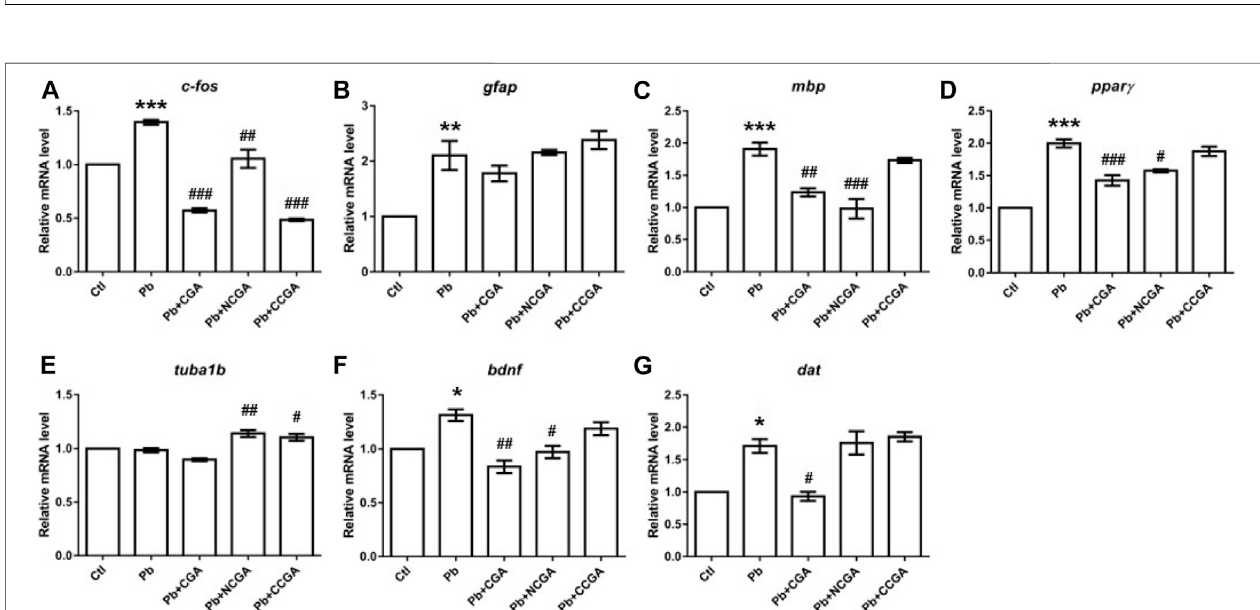
FIGURE7| Transcriptionofgenesrelatedtoneurodevelopment.ThegraphplotisrepresentedasfoldchangesinthemRNAexpressionofc-fos (A) ,gfap (B) ,mbp (C) , ppar γ (D) , tuba1b (E) , bdnf (F) , and dat (G) . Data were represented as mean ± SEM, n (cid:1) 3, and statistically analyzed by one-way ANOVA followed by Dunnett ’ s multiple comparison test. * p < 0.05, ** p < 0.01, *** p < 0.001 vs. control and # p < 0.05, ## p < 0.01, ### p < 0.001 vs. Pb.